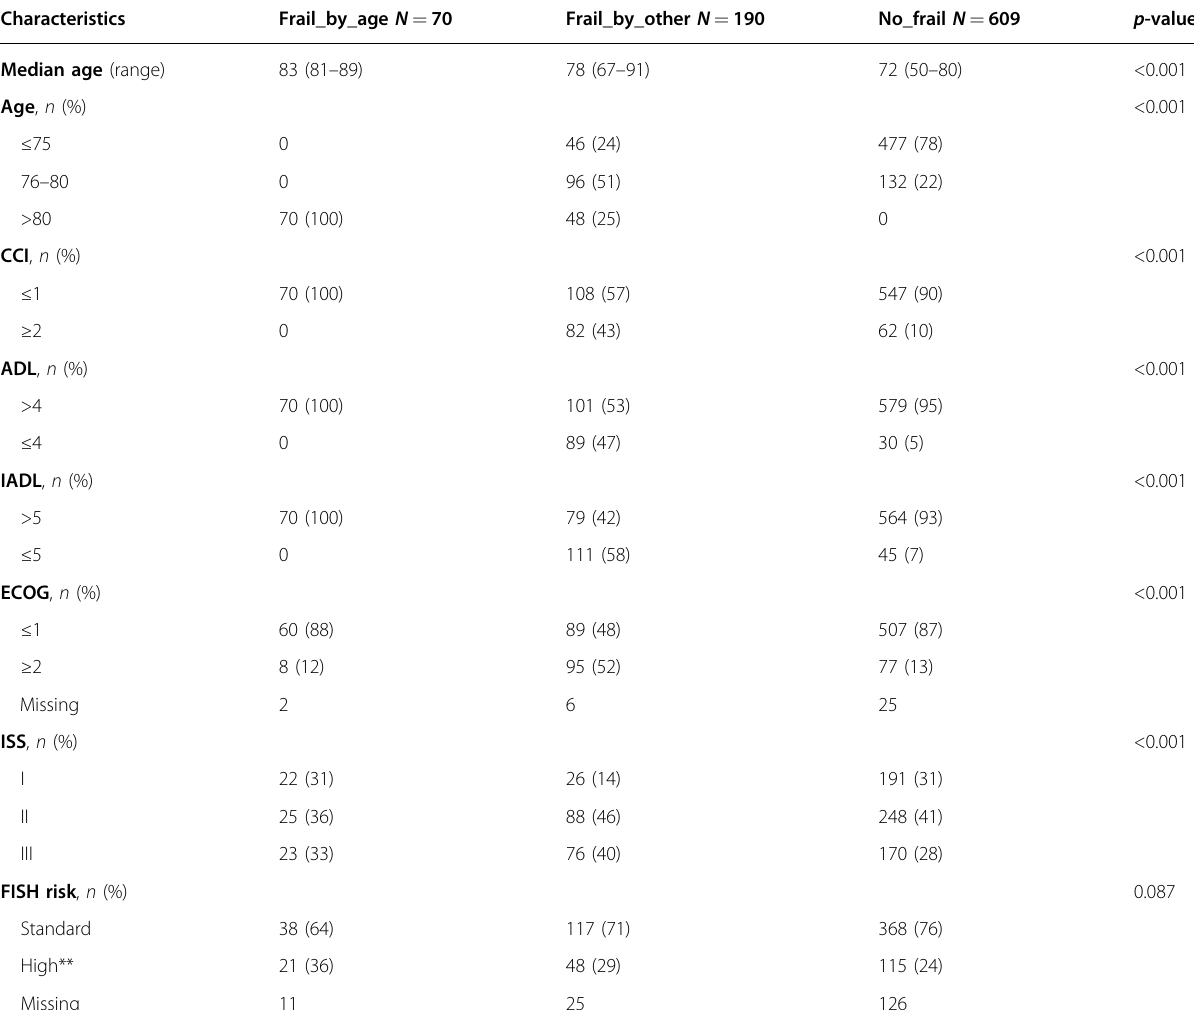
Table 1 Baseline characteristics of Frail_by_age, Frail_by_other, and No_frail patients.